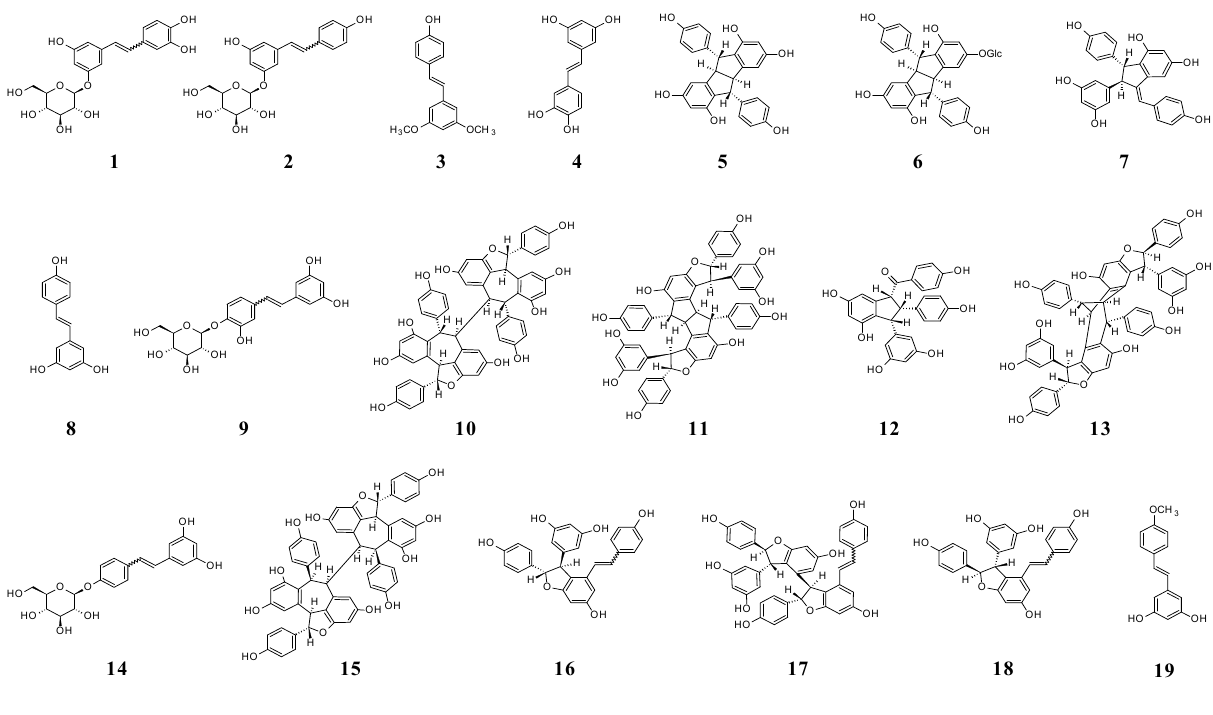
( 17 ) E- and Z-miyabenol C; ( 18 ) E- and Z- δ -viniferin; ( 19 ) trans -resveratrol-4'- methyl